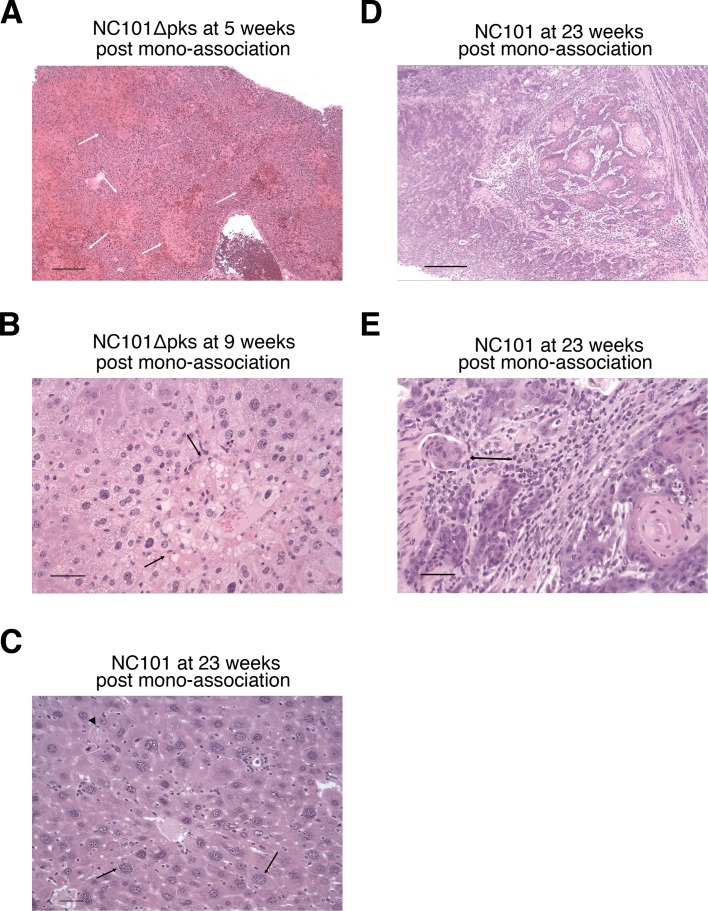
Histopathology of mouse tissues.This is from the same experiment as in Figure 2. Tissues were fixed, sectioned, and stained with hematoxylin and eosin (H&E). (A) Liver from a mouse that was mono-associated with NC101Δ
pks and died acutely 2 days after the second AOM treatment (5 weeks after bacterial inoculation). There is widespread acute centrilobular coagulation necrosis and hemorrhage (arrows). Bar = 250 µm. (B) Liver from a mouse that was mono-associated with NC101Δ
pks and died 2 days after the 6th AOM treatment (9 weeks after bacterial inoculation). There is widespread hepatocellular vacuolation, anisocytosis, and focal necrosis (arrows). Bar = 50 µm. (C) Liver from a mouse that was mono-associated with NC101 and died 23 weeks after bacterial inoculation. Giant hepatocellular nuclei (arrows), single-cell necrosis (arrowhead), and disorganization of hepatic cords are evidence of ongoing liver damage. Bar = 50 µm. (D) Anal squamous cell carcinoma in a mouse that was mono-associated with NC101 and euthanized 23 weeks after bacterial inoculation. Bar = 250 µm. (E) Higher magnification of anal squamous cell carcinoma in D) showing neoplastic squamous cells invading the muscularis (arrow). Bar = 50 µm. Additional details for this experiment can be found at https://osf.io/pm5xa/.